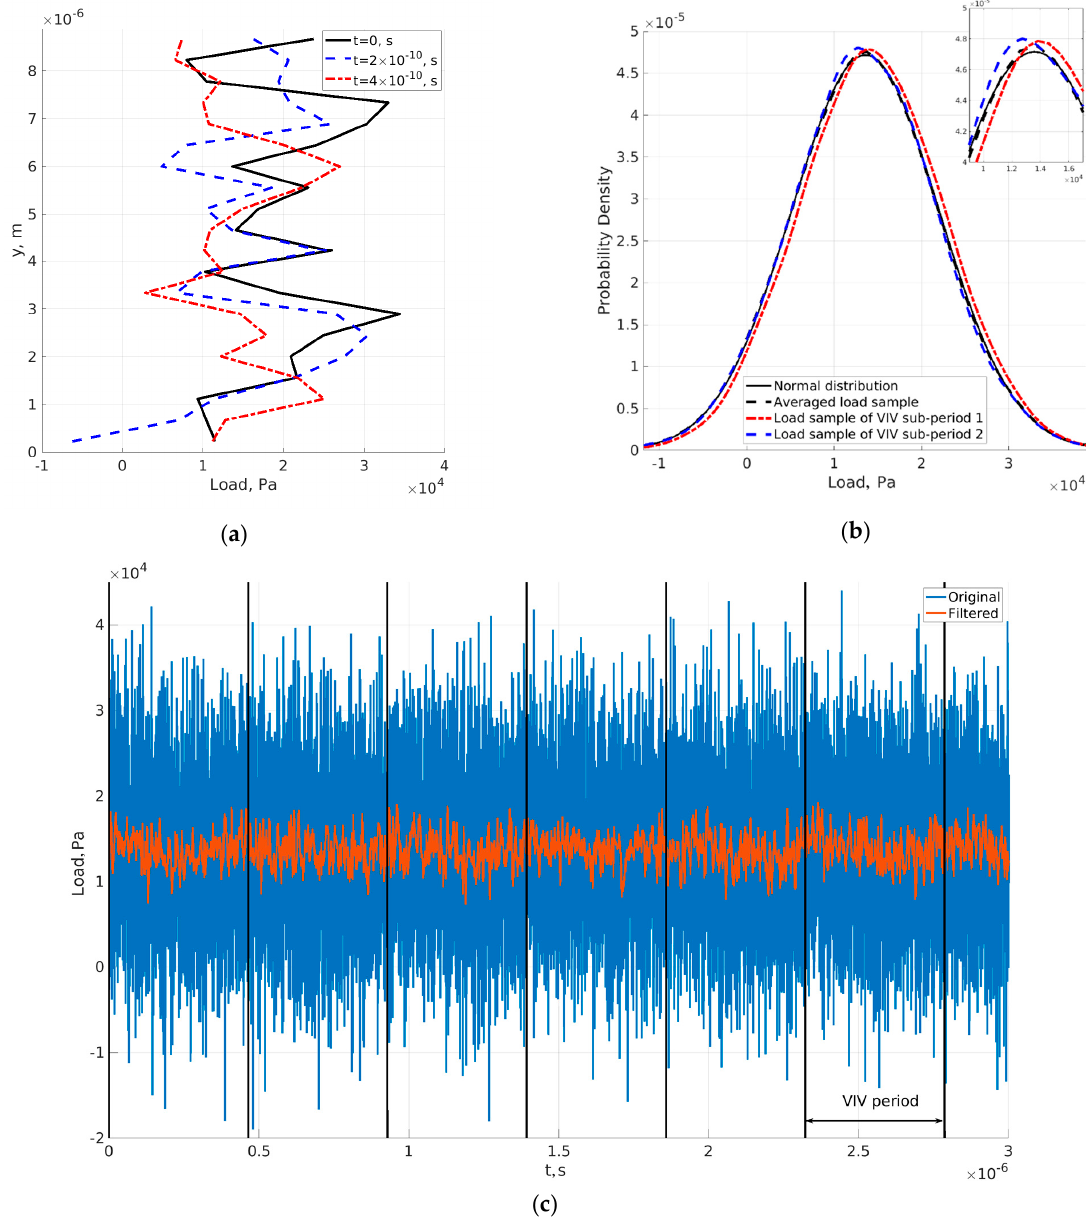
Figure 7. Load on beam. ( a ) Load along beam length for three sequential time steps; ( b ) probability density function of load of a node near the tip; ( c ) load at a node near the tip in time. Beam thickness is c h = 0.0201.